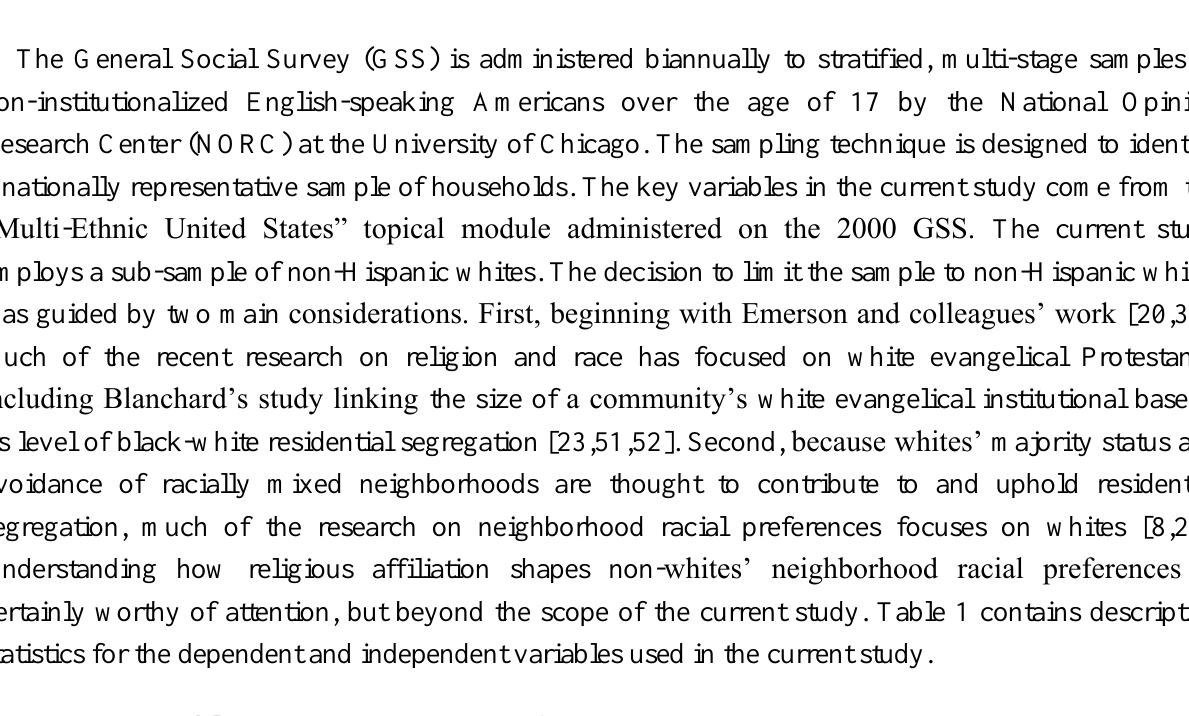
Table 1. Descriptive Statistics for Dependent and Independent